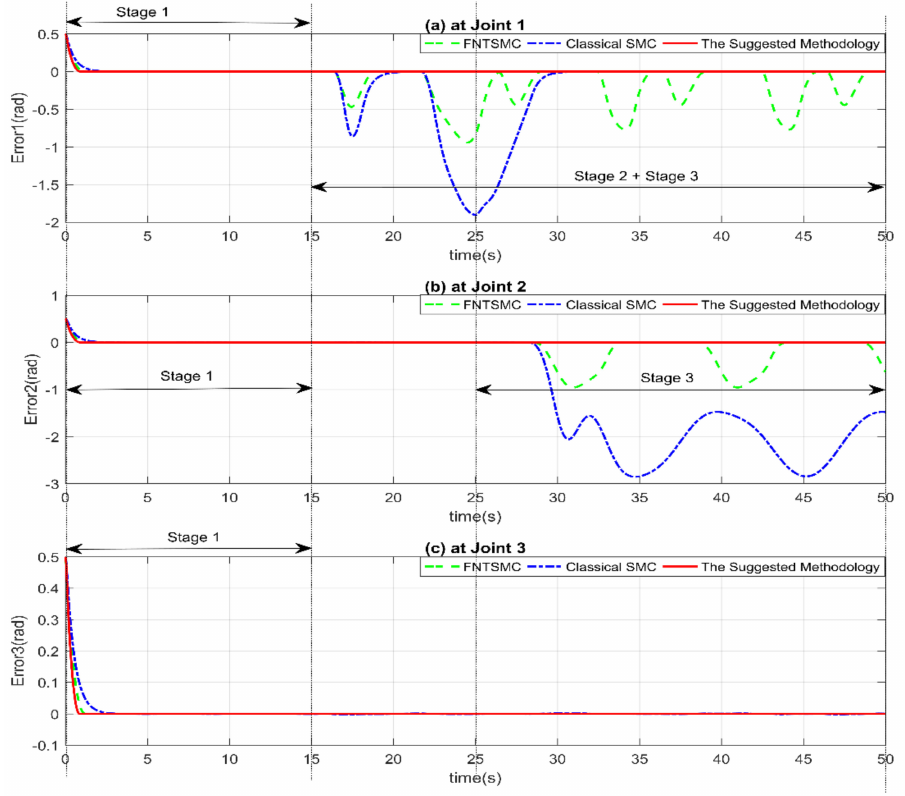
Figure 4. Trajectory tracking errors: ( a ) at Joint 1, ( b ) at Joint 2, and ( c ) at Joint